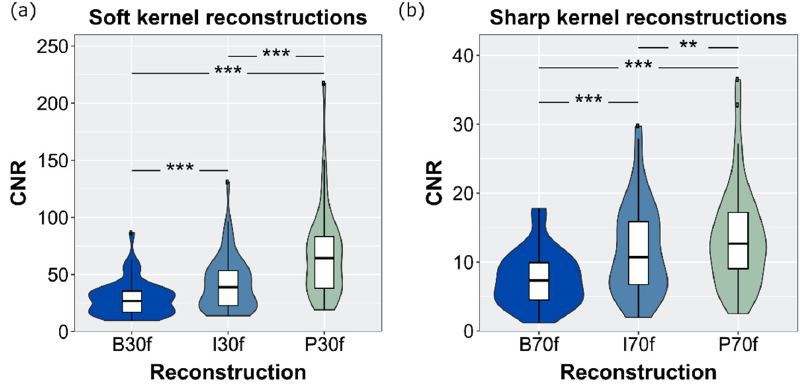
Figure 4. Contrast to noise ratio for ( a ) soft kernel and ( b ) sharp kernel reconstructions. Differ-